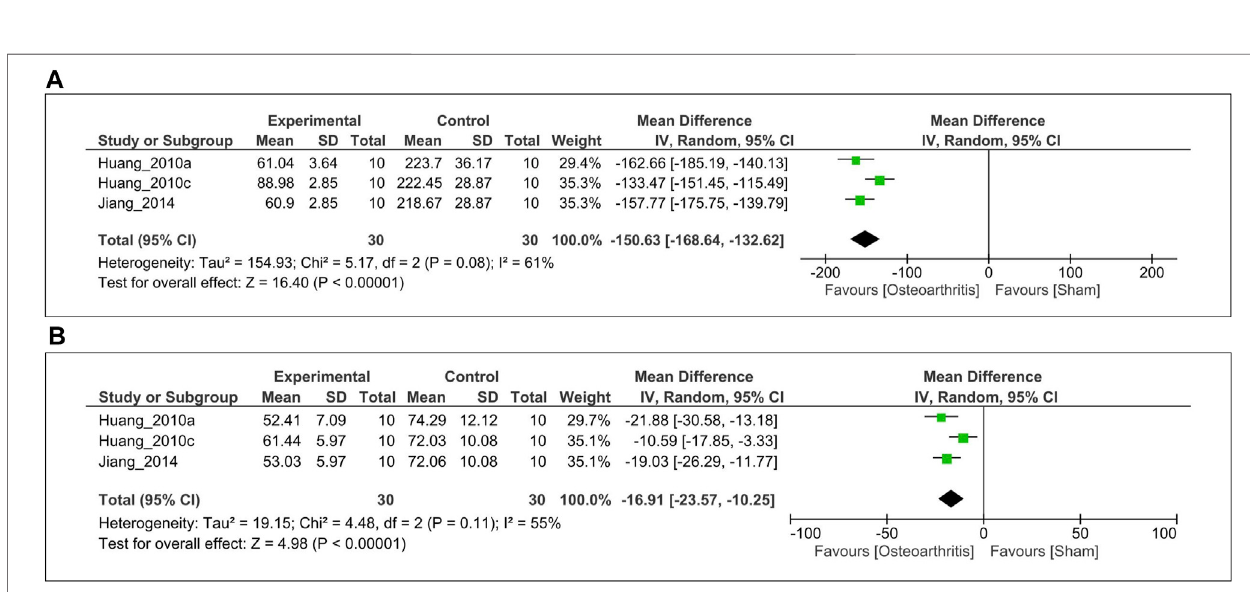
FIGURE 6 | Forest plot showing that serum MT levels. (A) 2 AM, and (B) 2 PM. The unit for MT is pg/ml. MT, melatonin; CI, con fi dence interval, IV, independent